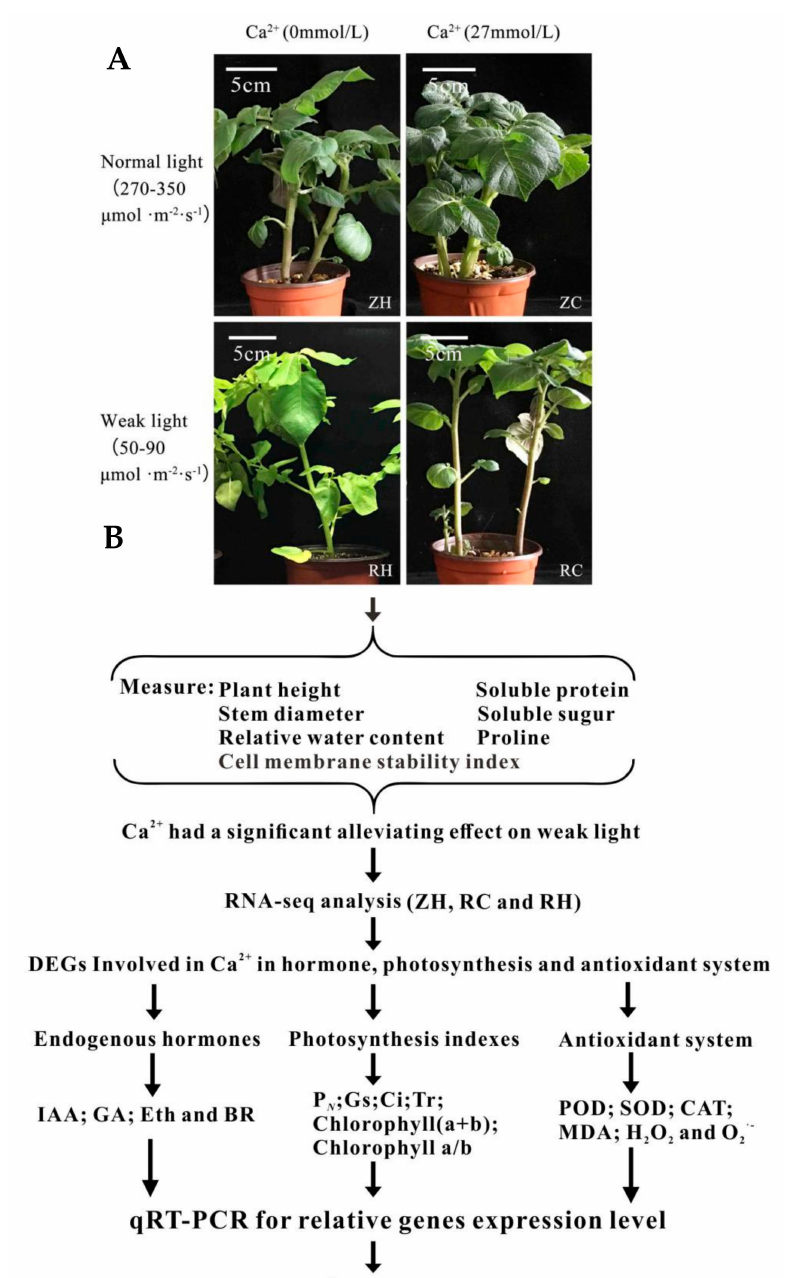
Figure 1. Potatoes were photographed and observed after treatment. ( A ) Potatoes served as a control group under normal light (ZH); the state of exogenous Ca 2 + under normal light (ZC); potatoes group under weak light (RH); the state of exogenous Ca 2 + under weak light (RC). ( B ) experimental design and flow chart designed for hormone, photosynthesis, antioxidant, and transcriptome